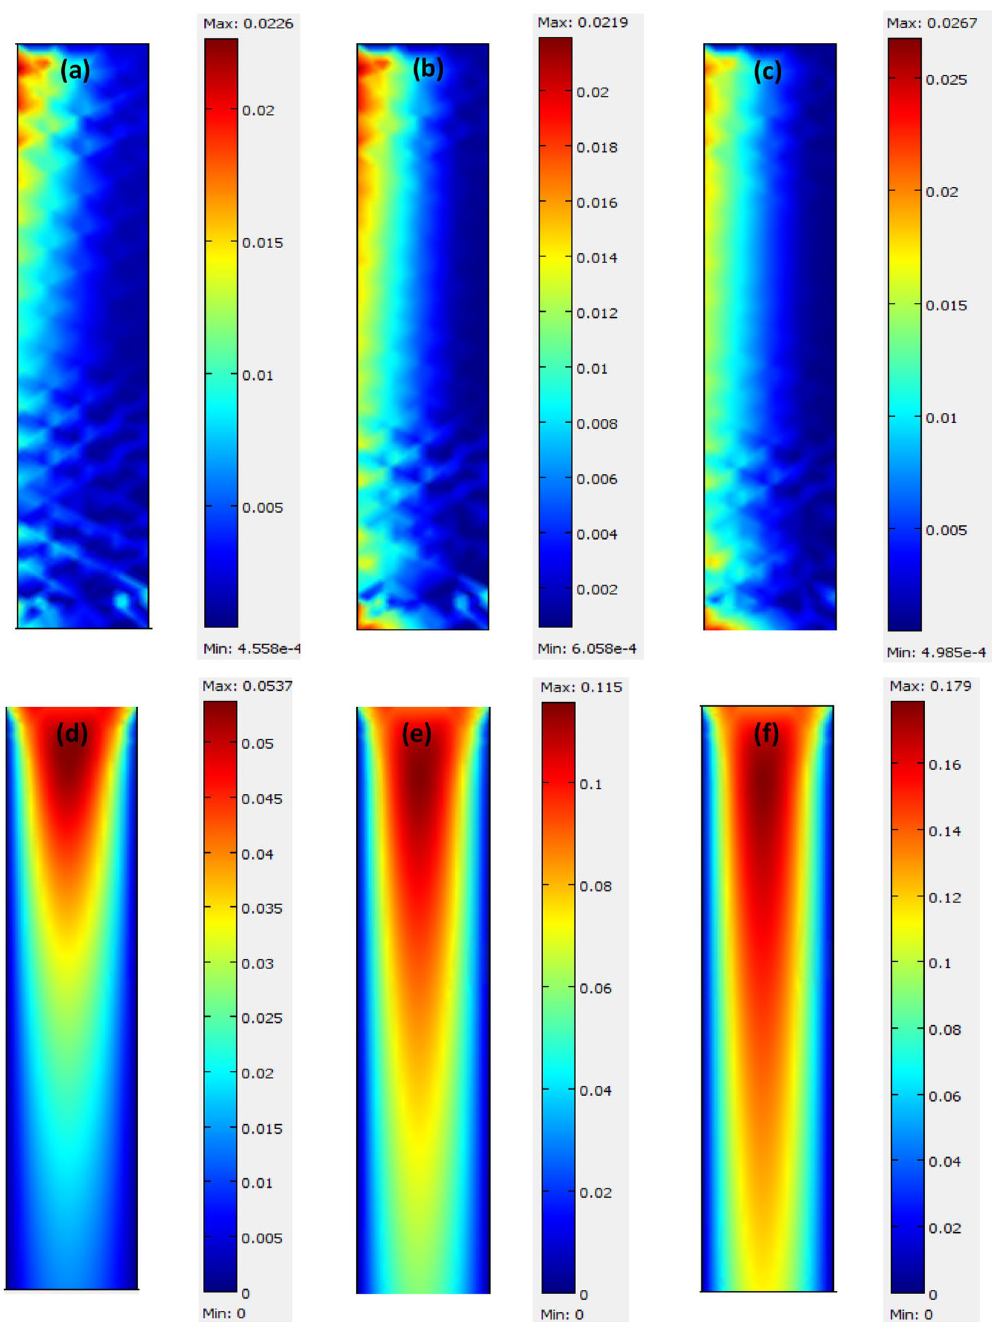
Figure 6. Effect of gas flow rate including 5 ( a , d ), 10 ( b , e ), and 15 ( c , f ) ml/min diffusive and convective CO 2 flux in the shell subdomain of contactor; 0.5 wt% CNT NPs; solvent flowrate = 10 ml/min; ( a – c ) diffusive flux and ( d – f ) are convective